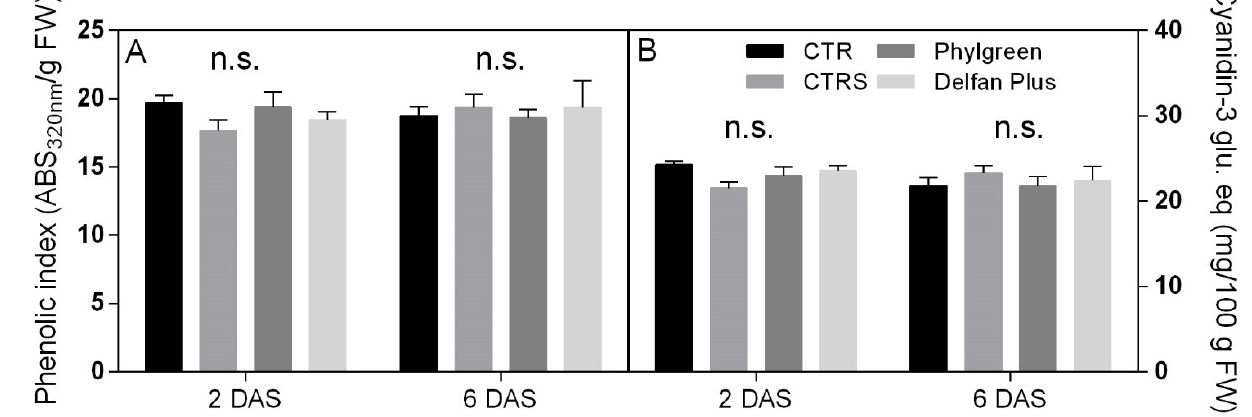
Figure 7. Total phenols expressed as phenolic index ( A ) and anthocyanin content ( B ) measured in Arabidopsis thaliana plants ( n = 5) treated in CTR, CTRS, Phylgreen, and Delfan Plus. Data were subjected to two-way ANOVA and no differences were found.